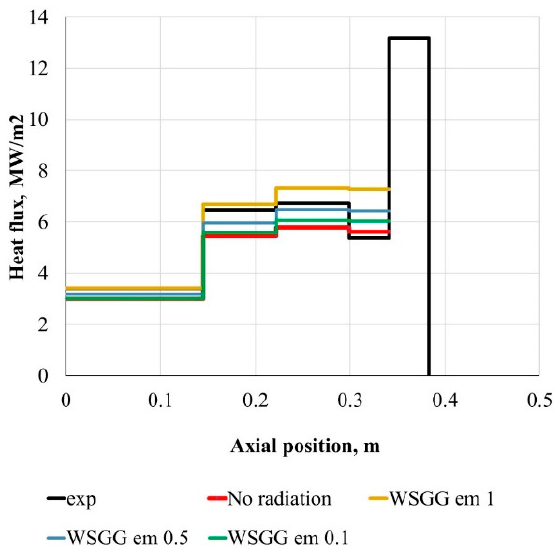
Figure 30. Pressure axial distribution.